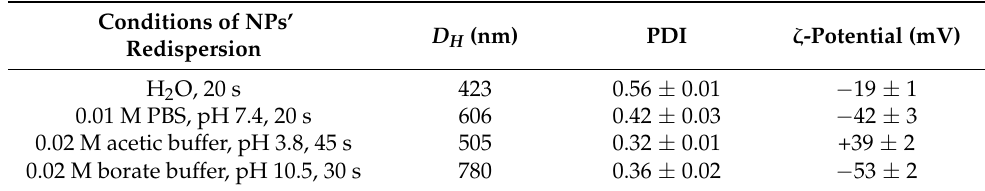
Table 2. Characteristics of Cys@Ag nanoparticles determined by dynamic and electrophoretic light scattering.